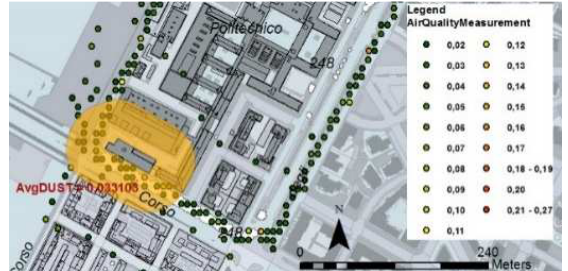
Figure 6: GIS layout showing an example of possible spatial analysis of dynamic data in the area of the Politecnico in Turin: the average of the values measured in a 50 m buffer of a buildings can be calculated and associated to the selected building.